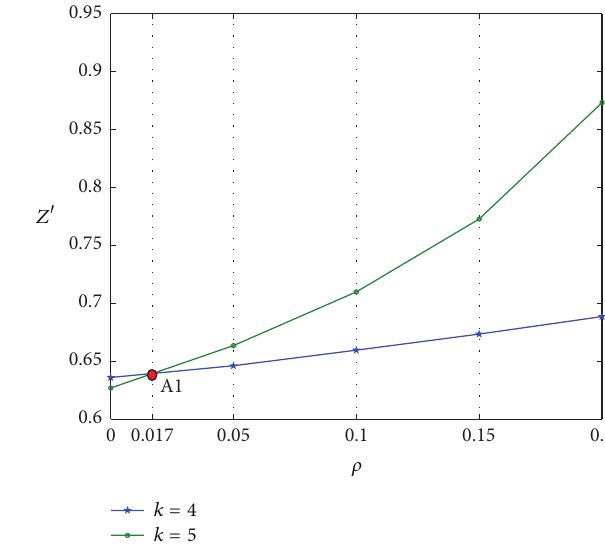
Figure 10: Curve of 𝑍 󸀠 varied with 𝜌 .